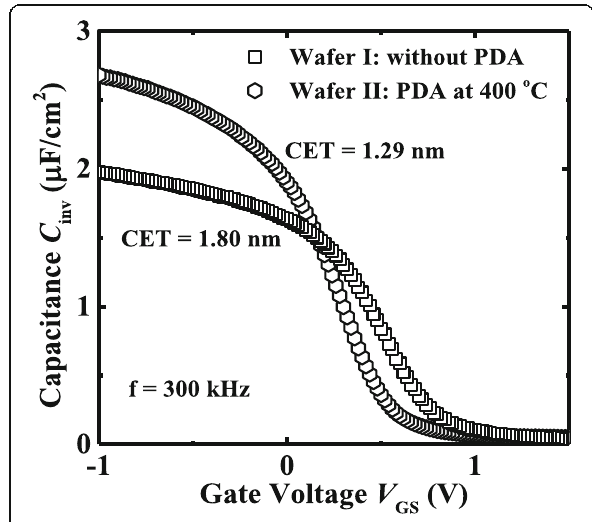
Fig. 6 C inv -V GS plots for the devices on wafer I and II with a PMA at 400